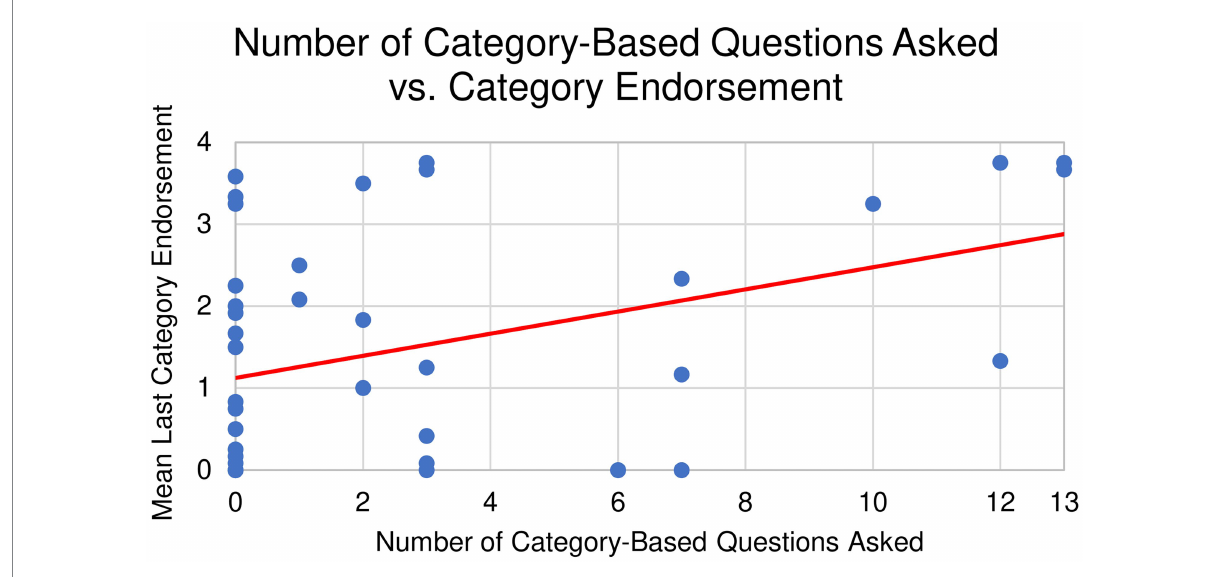
FIGURE 9 Bivariate correlation between category-based questions and category